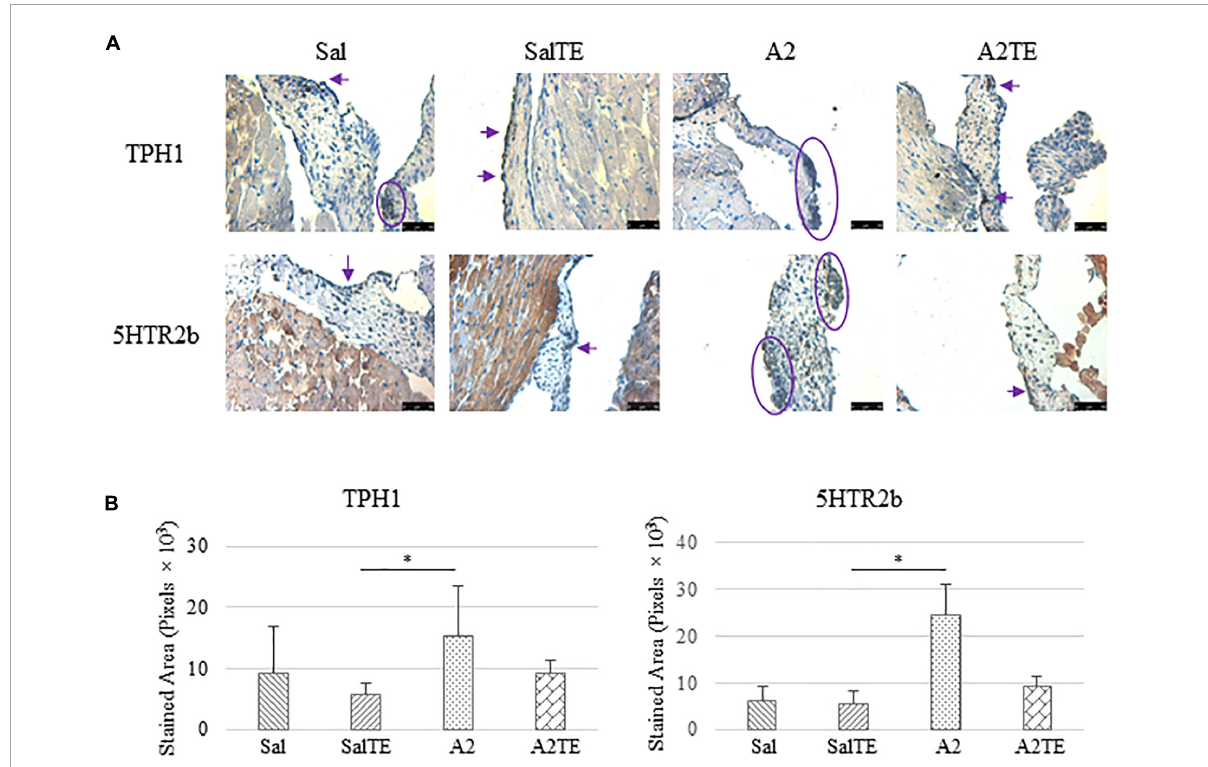
FIGURE10 (A) Investigation of local serotonin signaling in mitral valve by IHC examinations on TPH1 and 5HTR2b in reversal study. Major positive IHC stains were highlighted by circles and arrows. Scale bar: 50 µ m. (B) Quantification of their expression determined by total stained area in pixels that measured from 4 biological replicates in MATLAB. Asterisk indicates significant difference ( p <